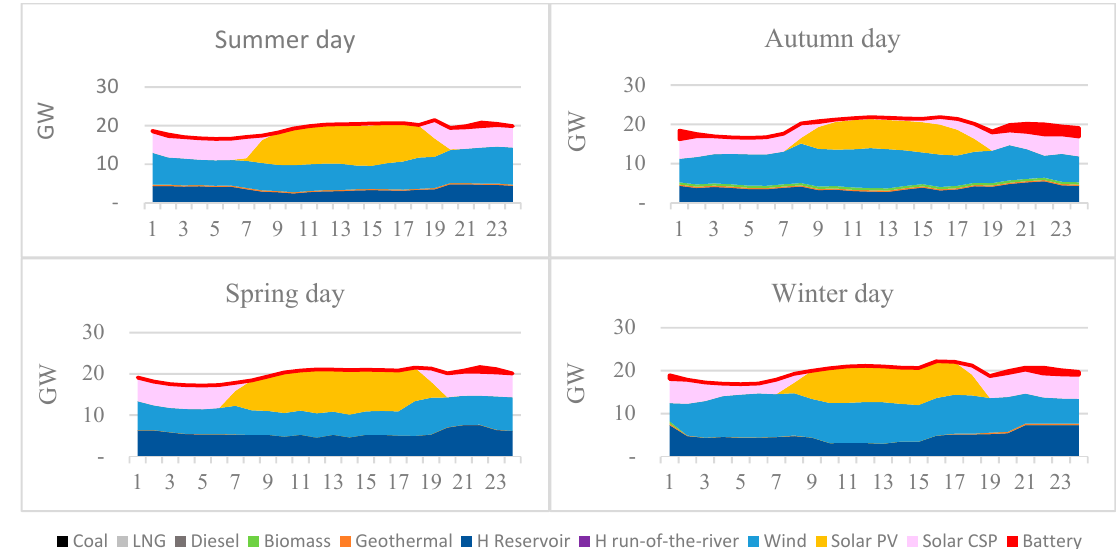
Energies 2021 , 14 , x FOR PEER REVIEW Figure 7. Load curves for a typical weekly day of each season in 2050, in the 100% renewable scenario.